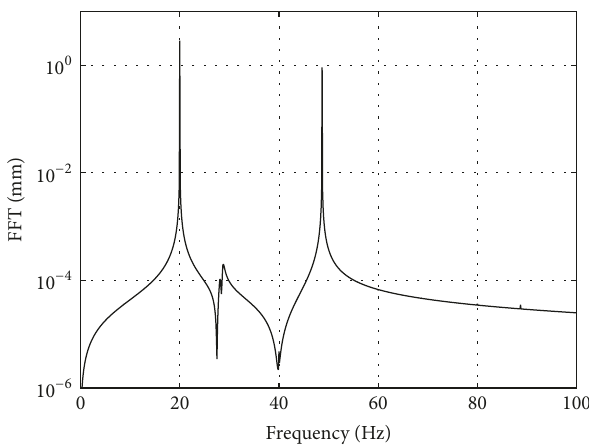
Figure 4: FFT of the system vibration responses at node #8 as excited by the diagnostic frequency of 48.7 Hz at node #4 (rotating speed of